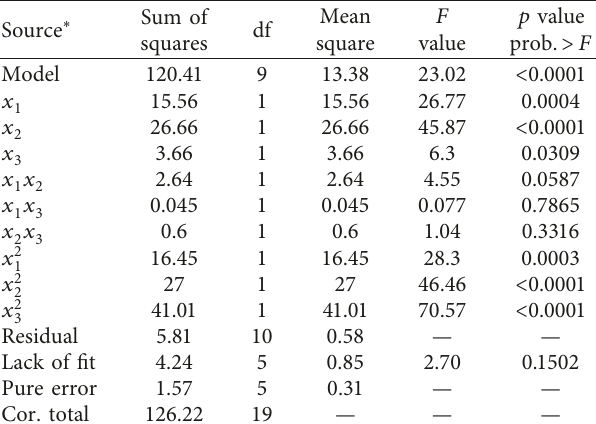
Table 4: The element analysis of each sample. Table 5: Test of significance of the quadratic equation coefficient and ANOVA for the response surface quadratic